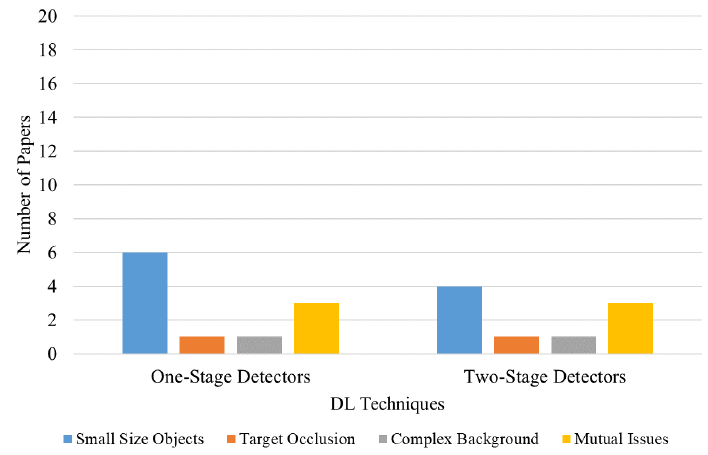
Figure 15. Applicability of DL approaches for handling problems in target